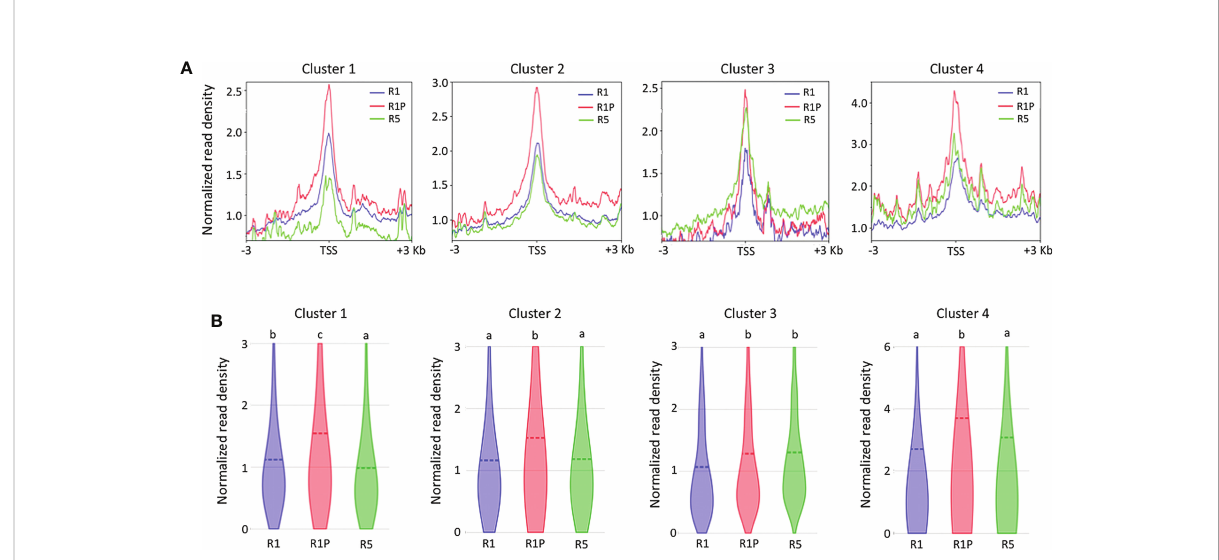
FIGURE 3 Differences in chromatin accessibility of genes belonging to each cluster among R1, R1P and R5. (A) TSS enrichment scores from ATAC-seq were plotted at ±3 Kb of the transcription start site (TSS) of genes in each cluster. (B) Violin plots showing normalized read density of genes (1 Kb promoter + mRNA) in each cluster at R1, R1P and R5. Dashed lines represent the mean value for each sample. Different letters indicate signi fi cant differences (* P < 0.01, Steel – Dwass